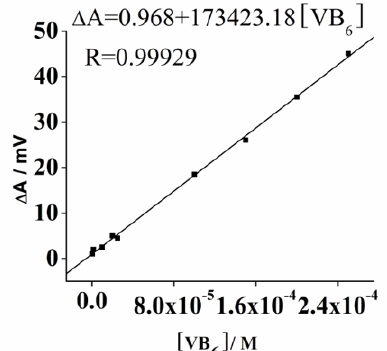
Figure 3. Plotting of changes in amplitude ( ∆ A) vs. concentration of pyridoxine hydrochloride in the range 5×10 -7 to 2.5×10 -4 M. (Common conditions: [NaBrO 1.95×10 -2 M, [H SO ] = 1.0 M, [malic acid] = 0.18 M, 2 4